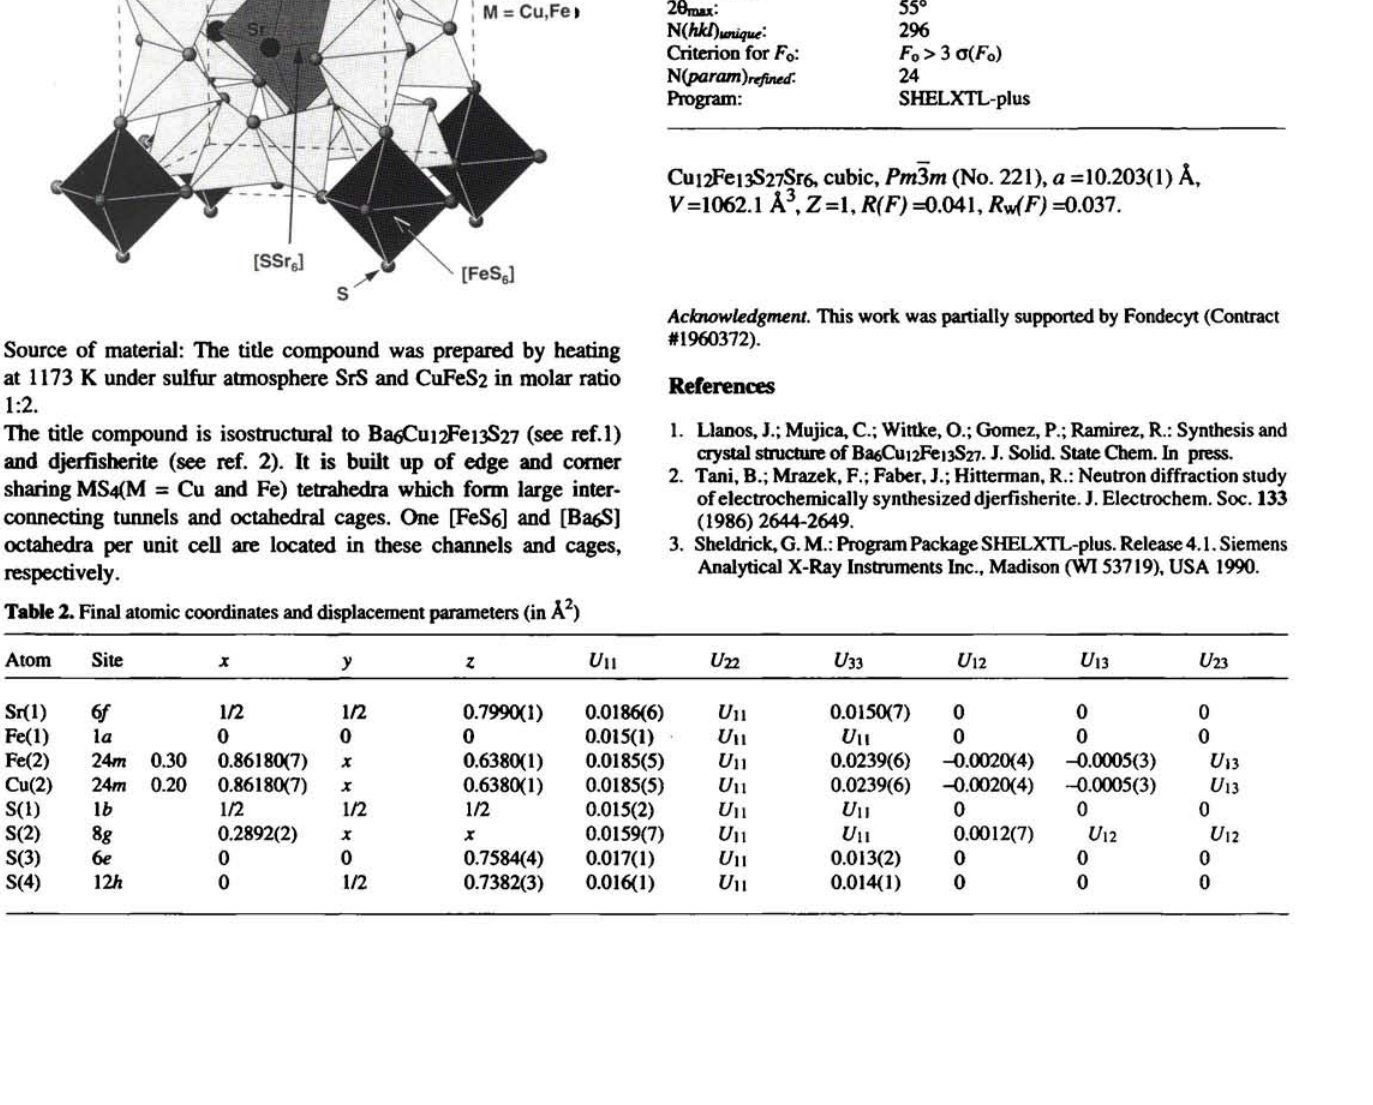
Table 1. Parameters used for the X-ray data collection